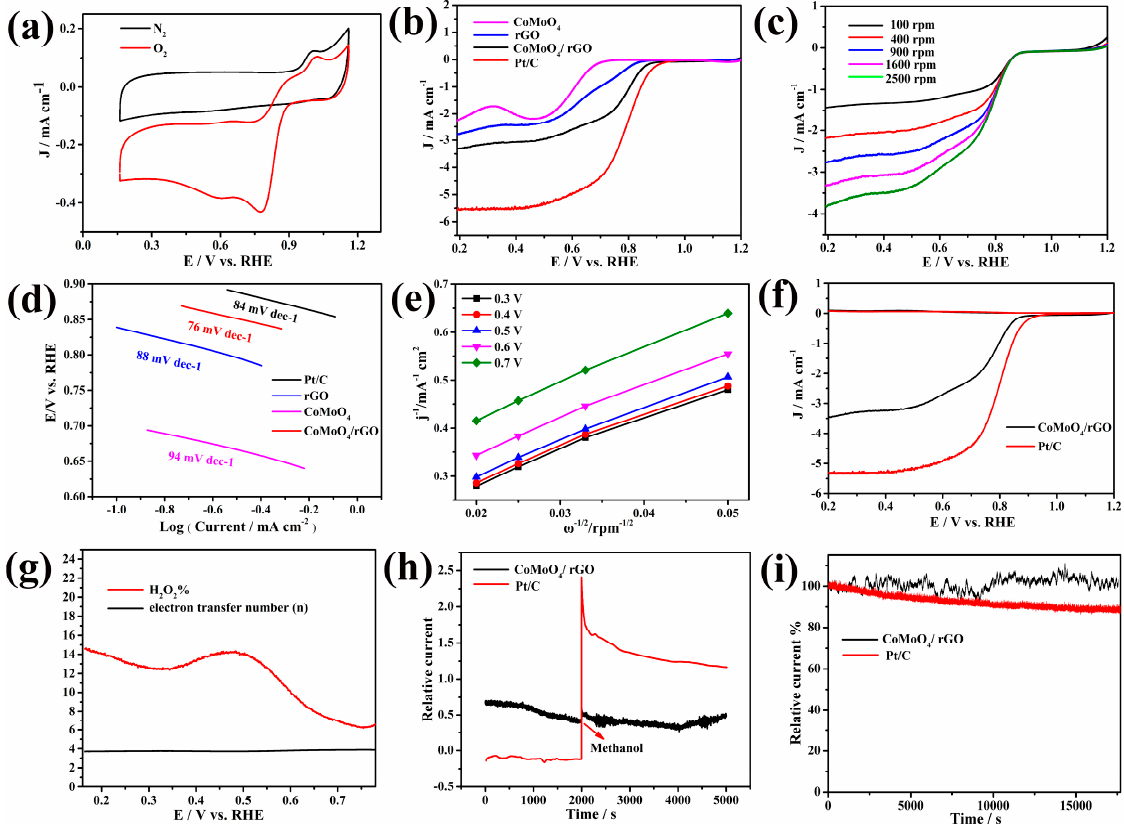
Figure 4 . ( a ) CV curves of CoMoO 4 /rGO in O 2 -saturated (red line) or N 2 -saturated (black line) 0.1 M KOH with a scan rate of 10 mV s − 1 ; ( b ) linear sweep voltammetry (LSV) curves of CoMoO 4 , rGO, CoMoO 4 /rGO, and Pt/C nanocomposites in O 2 -saturated 0.1 M KOH with a sweep rate of 5 mV s − 1 at 1600 rmp; ( c ) LSV curves of CoMoO 4 /rGO at various rotation speeds with a sweep of 5 mV s − 1 ; ( d ) Tafel plots of CoMoO 4 , rGO, CoMoO 4 /rGO, and Pt/C in O 2 saturated 0.1 M KOH at a scan rate of 5 mV/s, rotation rate = 1600 rpm; ( e ) Koutecky–Levich plots of CoMoO 4 /rGO at different electrode potentials; ( f ) rotating ring disk electrode (RRDE) voltammograms of CoMoO 4 /rGO and Pt/C; ( g ) The transfer electron number (n) and hydrogen peroxide yield (H 2 O 2 %) curves of CoMoO 4 /rGO material; ( h ) Current-time (I-t) curves of CoMoO 4 /rGO and Pt/C with the addition of 1 M methanol; ( i ) the relative retention of current vs. Time in O 2 -saturated 0.1 M KOH solution for CoMoO 4 /rGO and Pt/C.